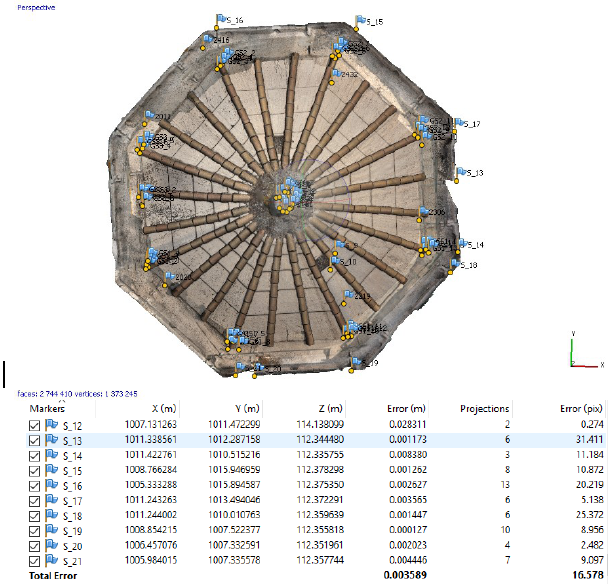
Figure 12: The adjustment results for the images of the slab roof